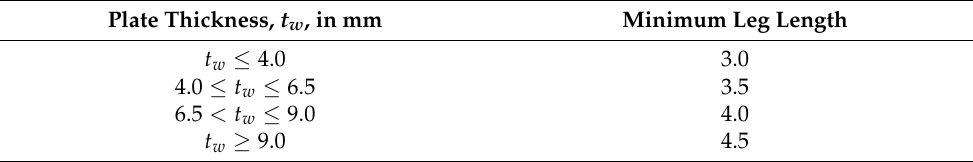
Table A1. Minimum leg length for plate